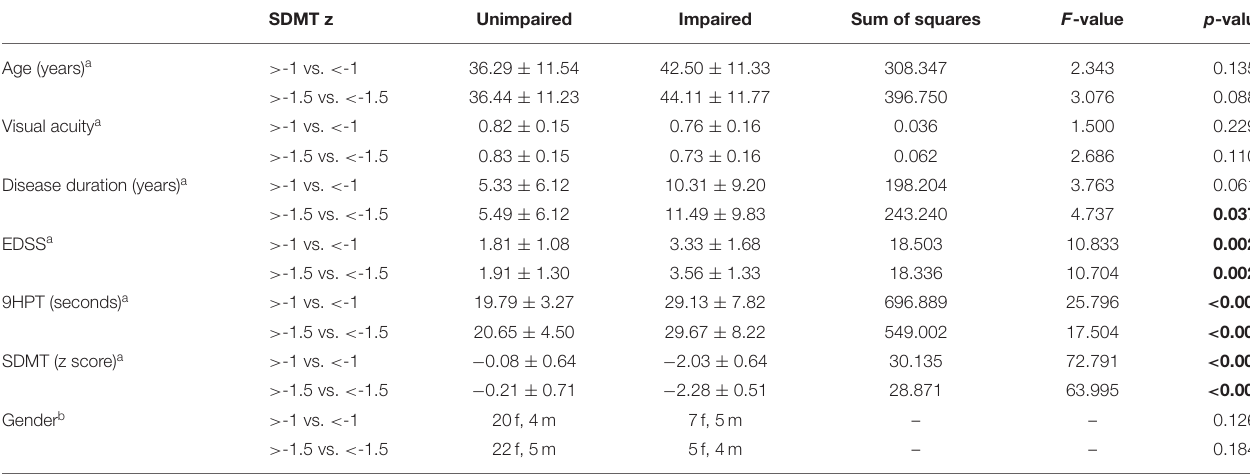
TABLE 1 | Demographic and clinical characteristics of the patients. SDMT z Unimpaired Impaired Sum of squares F -value p -value